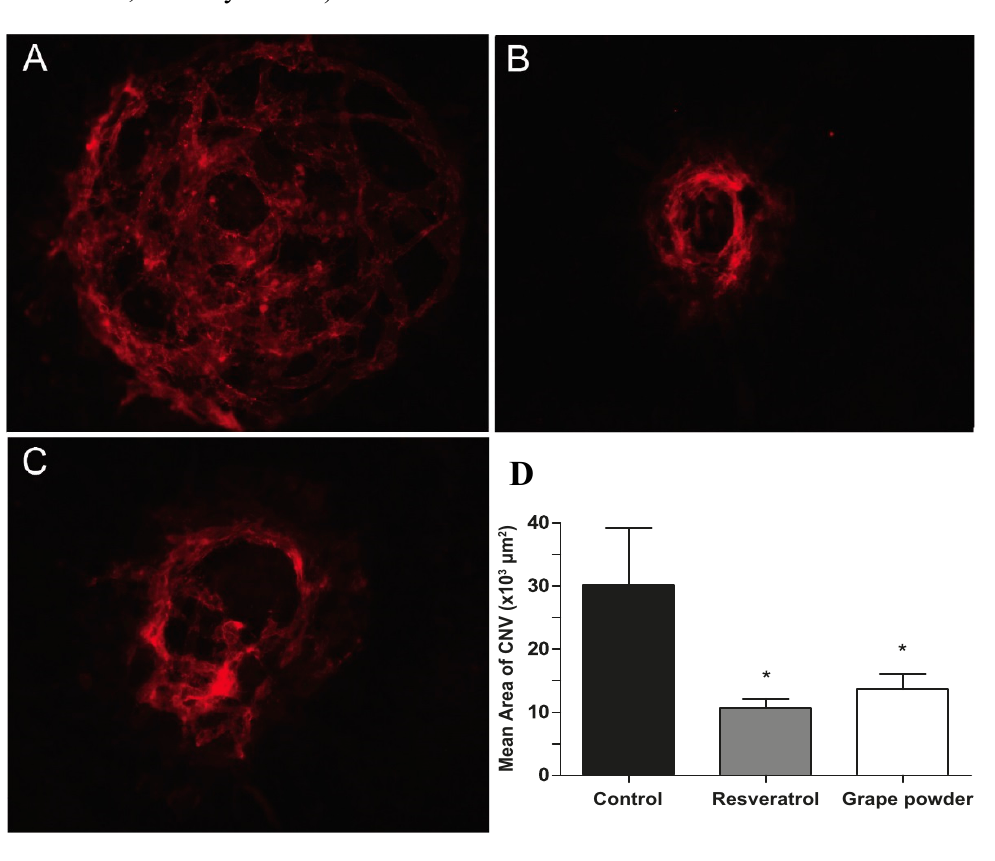
Figure 2. Resveratrol and reconstituted grape powder reduce blood vessel formation in a mouse model of CNV. Representative sclerochoroidal flat mounts after staining with intercellular adhesion molecule-2 antibodies; CNV in mice that received vehicle ( A ), resveratrol ( B ) or reconstituted grape powder ( C ) in their drinking water. Treatment began twelve days prior to the induction of CNV and continued for a total of 24 days. ( D ) Quantification of the data ( * p value resveratrol = 0.018, n = 5 eyes); * p value grape powder = 0.042, n = 5 eyes